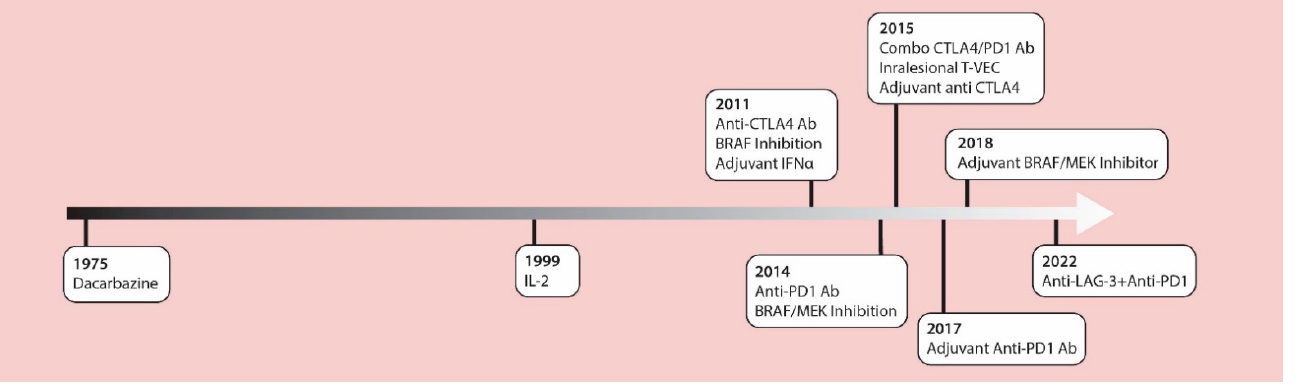
Figure 1. A timeline of FDA approved therapies for late-stage melanoma. IL-2 = interleukin-2; IFN α = interferon alpha; CTLA-4 Ab = cytotoxic T lymphocyte associated protein-4 antibodies; LAG-3 = lymphocyte activation gene-3; PD-1 Ab = programmed cell death-1 antibodies; T-VEC = talimogene laherparepvec.